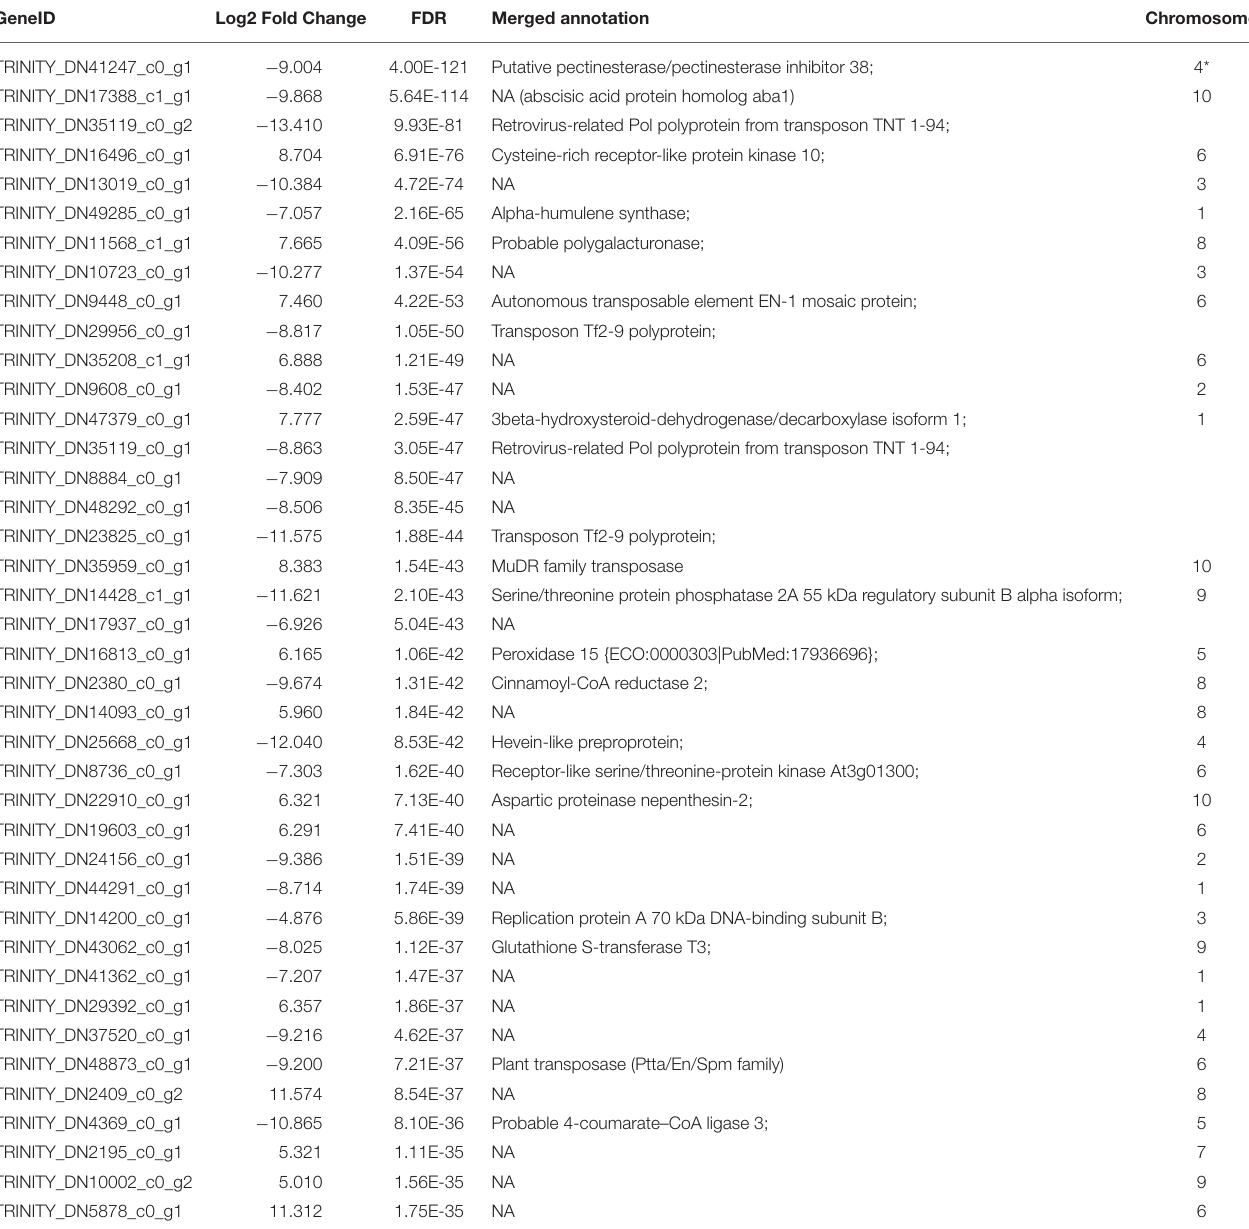
Top 40 most significant genes. Chromosome location as determined by top BLAST hit to B73 RefGenv3. The asterisks in the Chromosome column indicate BLAST hits were found in the genetically mapped location of Ga1. Where chromosome location is missing, significant BLAST hits were not found in the maize genome. In some cases BLAST hits were found